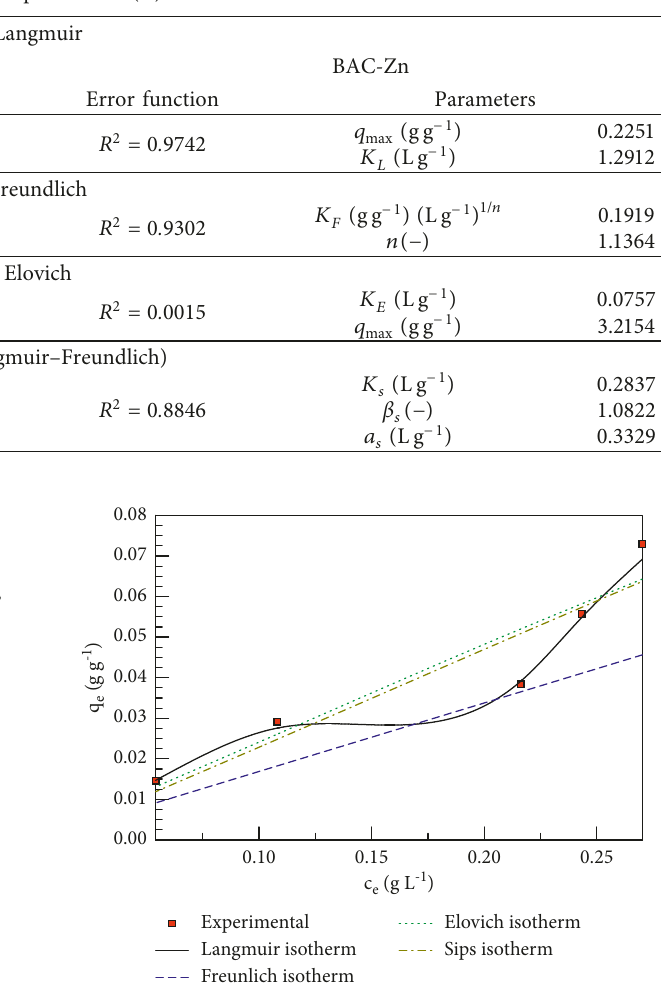
Figure 21: Adsorption isotherm models for Cu(II) ions adsorption onto the BAC-Zn adsorbent. Table 8: Separation factors for the adsorption of Cu(II) ions onto the prepared